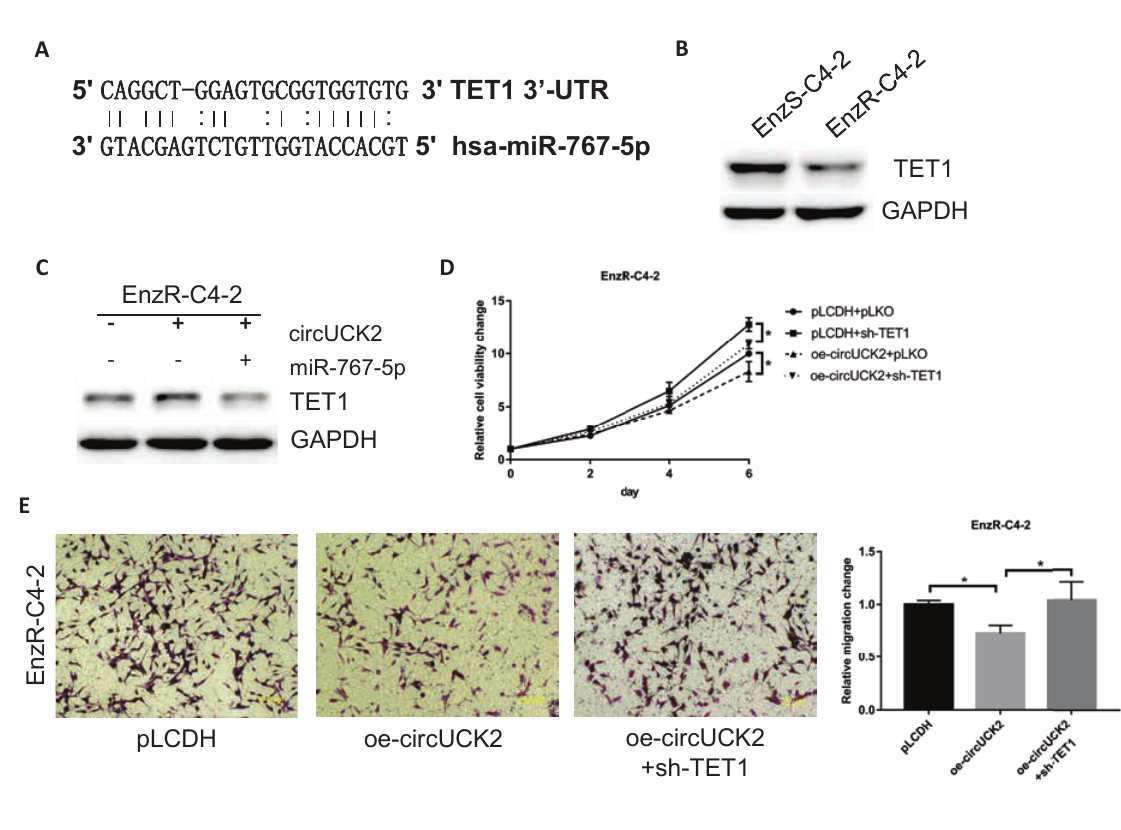
Fig. 3 Mechanism dissection of how circUCK2 can suppress PCa cell growth: via increase TET1